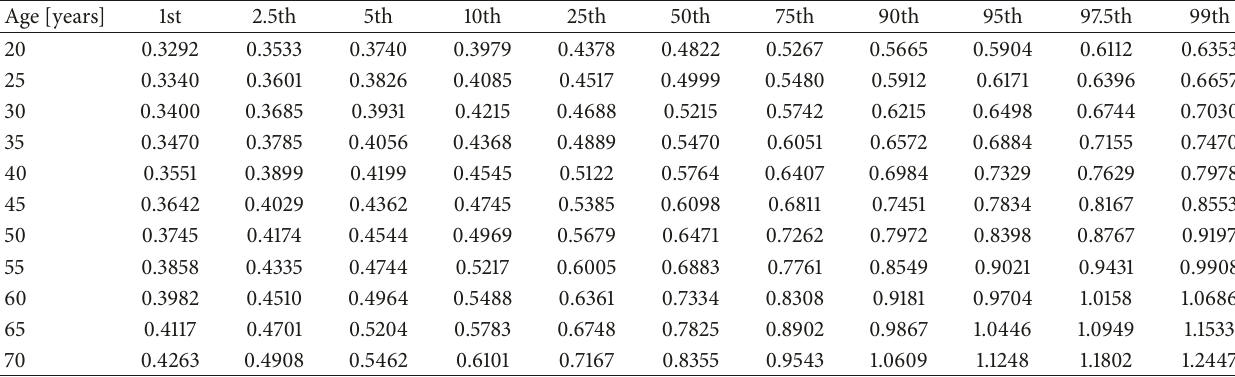
Table 9: Left common carotid intima media thickness [ mm ] percentiles for healthy male subjects.